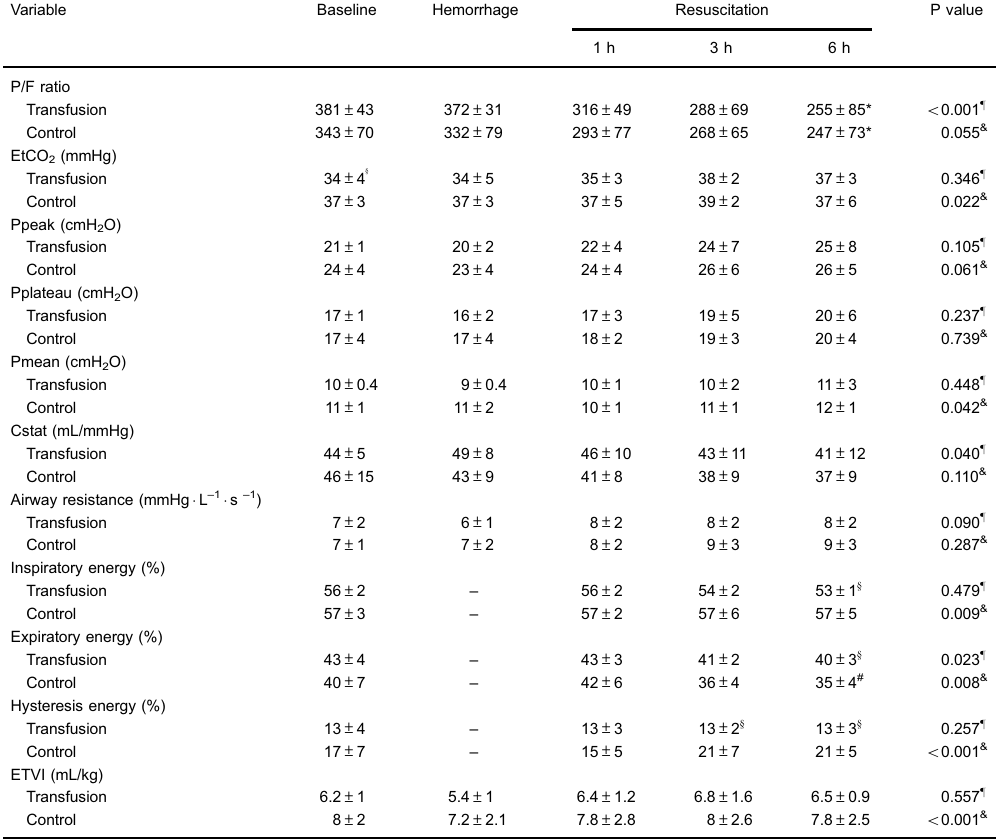
Table 2. Respiratory parameters of the groups during the study period. Variable